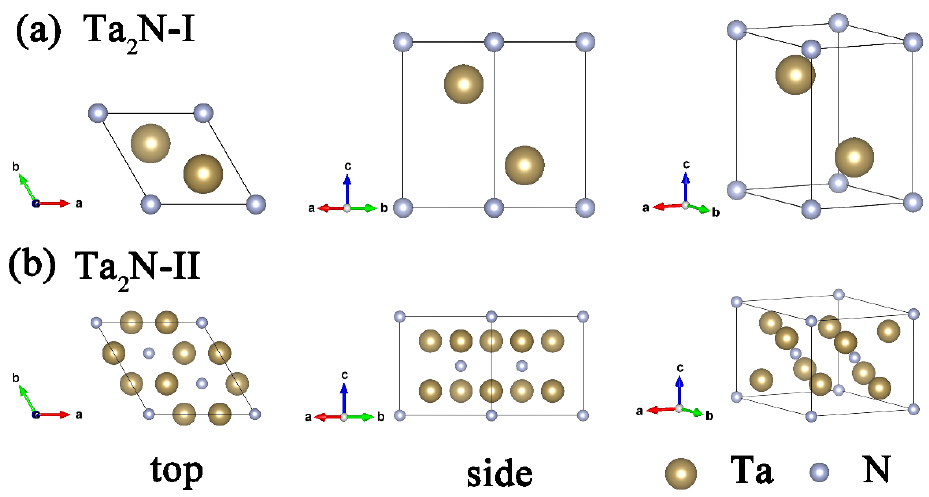
Figure 1. Structure sketch maps of ( a ) Ta 2 N-I and ( b ) Ta 2 N-II from different viewpoints. The k -point meshes were Γ -centered 17 × 17 × 9, 9 × 9 × 11, 15 × 15 × 15 for the bulk Ta 2 N-I, Ta 2 N-II, bcc Ta; and 1 × 1 × 1 for the molecule (N 2 ), respectively. Herein, total en-